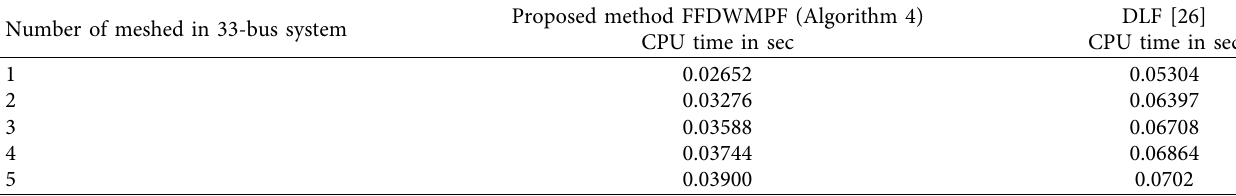
Table 7: Comparison of the CPU execution time of the balanced 33-bus weakly meshed system.